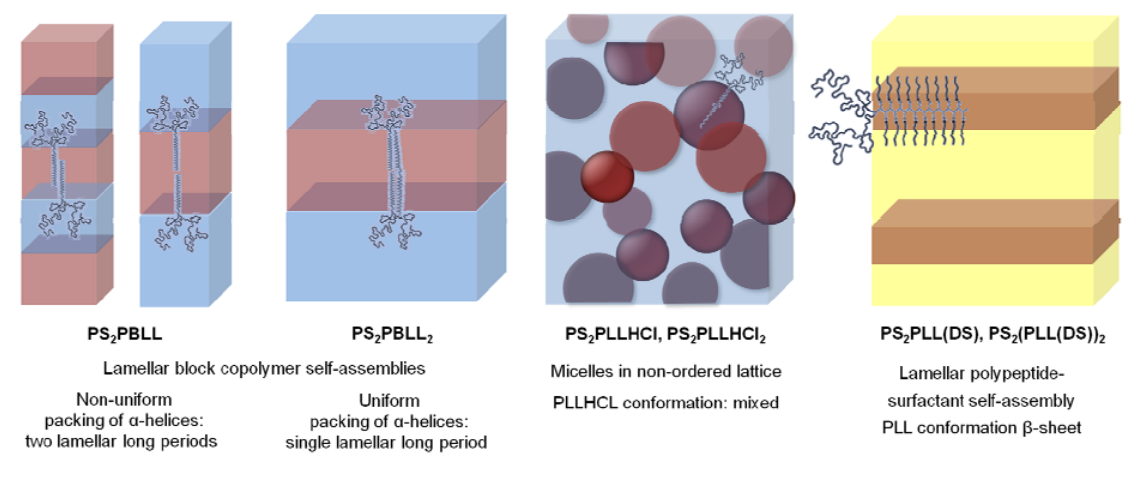
Scheme XI. Schematic illustration of the packing of the miktoarm molecules in bulk (pink, PS; yellow, polypeptide; blue, surfactant) based on